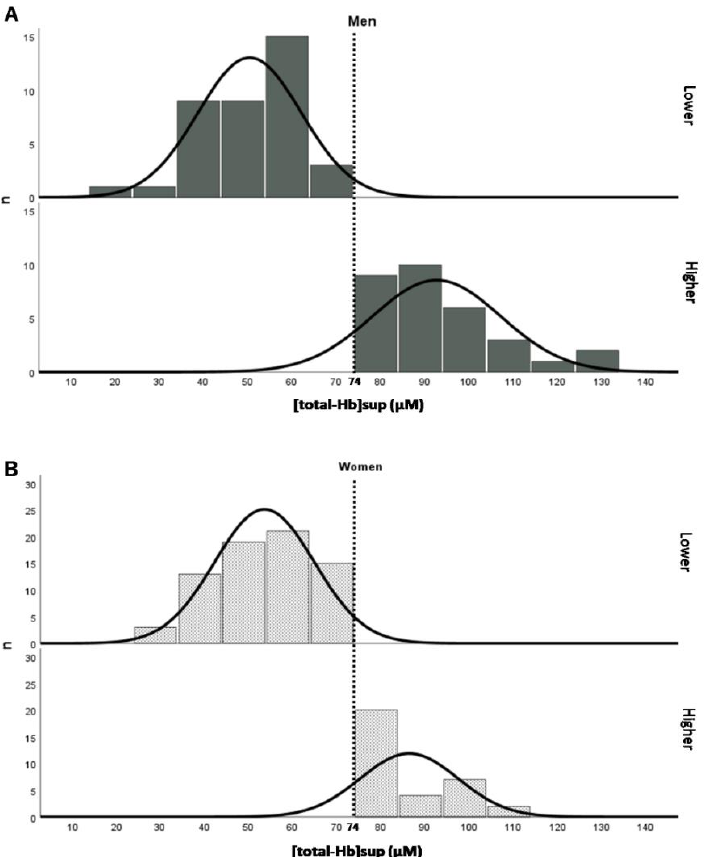
Figure 7. Histograms showing the [total-Hb]sup, a parameter of brown adipose tissue density (BAT-d), in men ( A ) and women ( B ) according to whether BAT was higher (>74 µM) or lower (<74 µM). [total-Hb]sup, total hemoglobin concentration in the supraclavicular region.